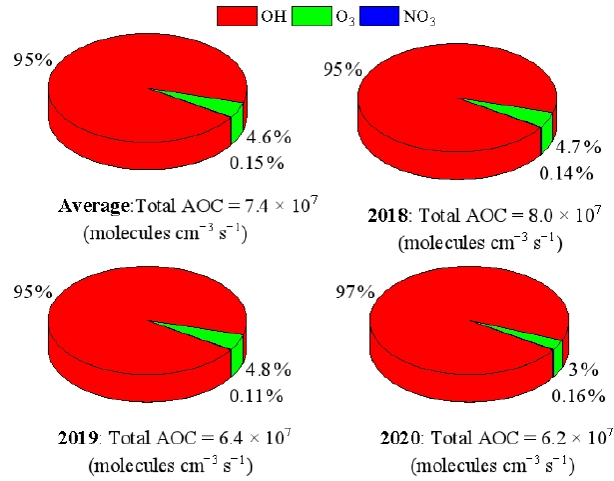
Figure 8. Comparison of the relative contributions of OH, O 3 , and NO 3 of the AOC in Zhengzhou during the sampling